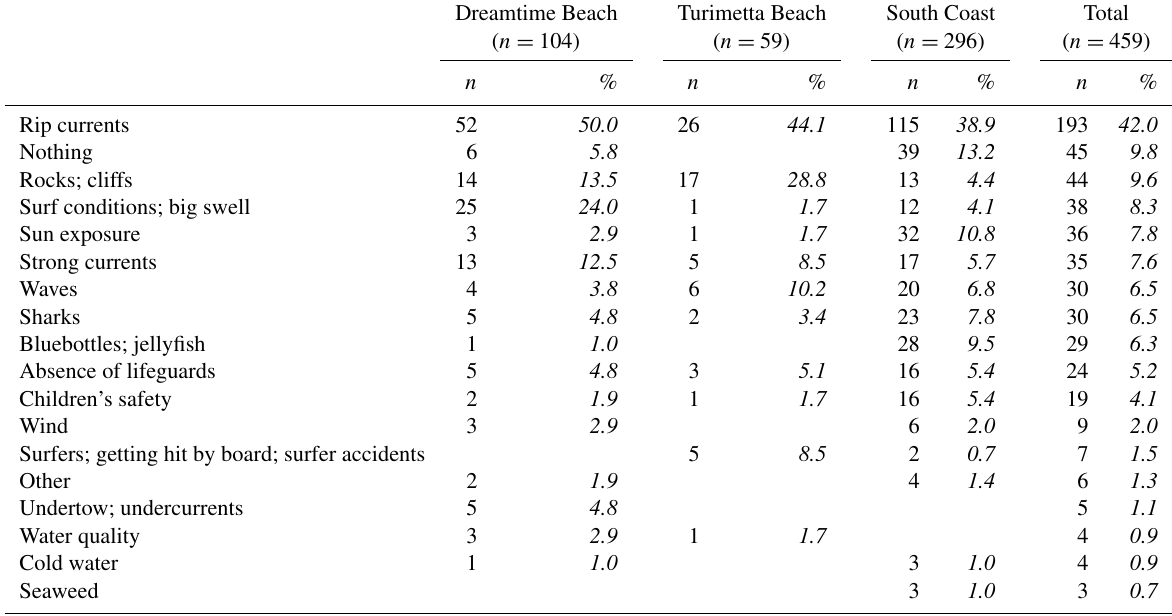
Table 2. Safety and hazard concerns at Dreamtime Beach, Turimetta Beach and the South Coast (total number of responses is greater than 459, as some survey respondents provided multiple answers). Percentages shown in italics were calculated by dividing by the total number of